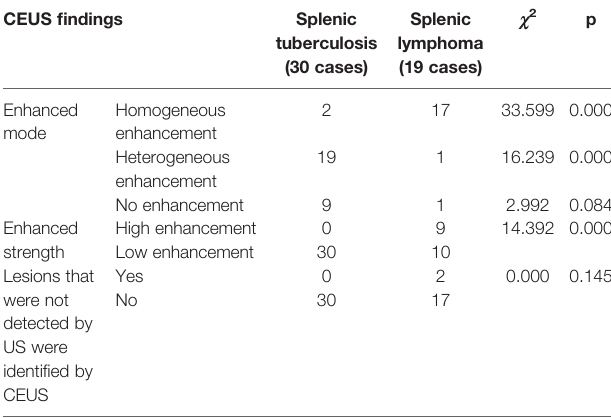
TABLE 2 | Comparison of splenic tuberculosis and splenic lymphoma by CEUS. CEUS fi